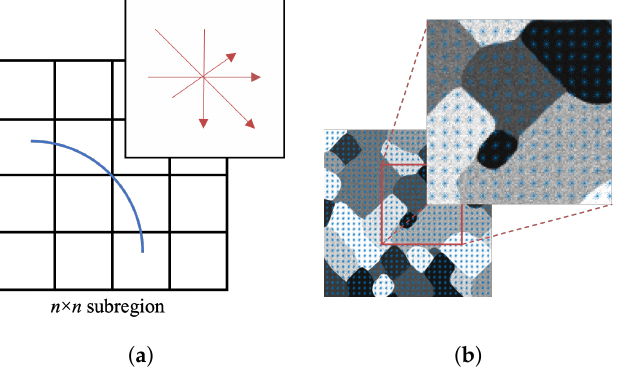
Figure 7. HOPES descriptor visualization: ( a ) subregion of HOPES descriptor; ( b ) HOPES gradient direction of simulated SAR